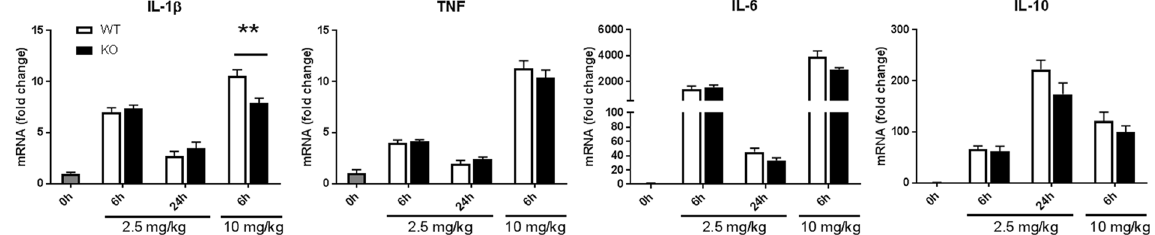
Figure 4. Cyokine expression in spleens of WT and ficolin KO mice after LPS challenge. Groups of WT and ficolin KO mice were intraperitoneally injected with LPS of a sublethal (2.5 mg/kg) or lethal (10 mg/kg) dose and sacrificed at indicated time points. Spleens were removed and expression of inflammatory cytokines in spleen homogenates was measured by qPCR. Data represent mean ± SEM as the fold increase over the control group (naive WT mice); n = 6–8 mice in LPS groups and n = 2 mice in the control group. ** p < 0.01 for WT to ficolin KO comparisons (unpaired two-tailed Student’s t